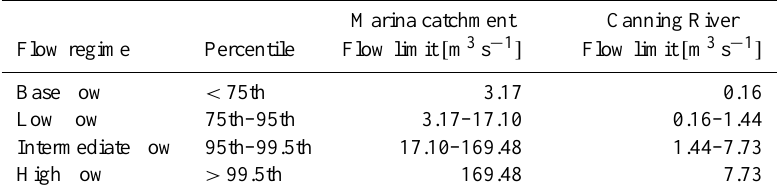
Table 8. Percentile-based categorised flow regimes for Marina catchment and Canning River.